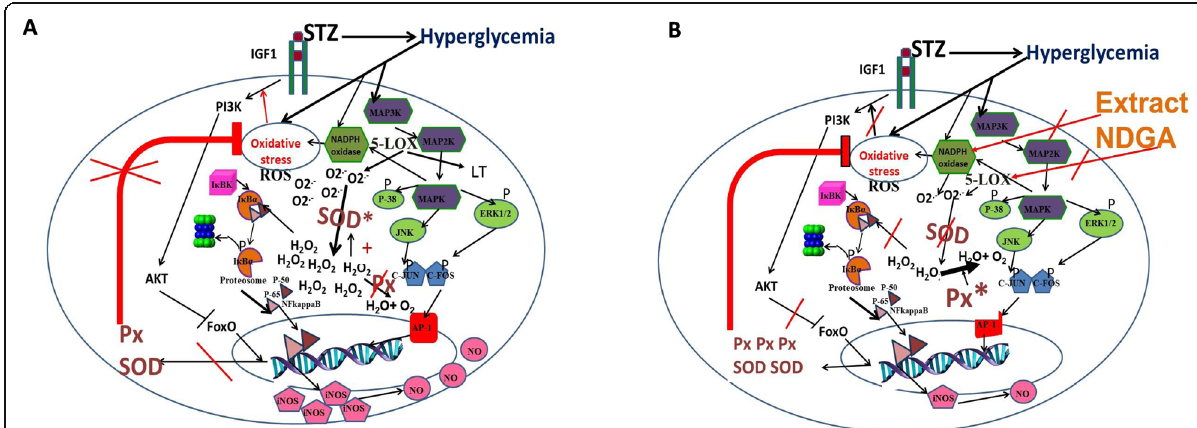
Fig. 7 Probable mechanism of the antioxidant action exerted by AE and NDGA on submandibular glands from diabetic rats. a - Hyperglycemia induces oxidative stress through MAPK, NADPH oxidase and 5-LOX activation. The ROS generated activate the IGF1R-PI3K-AKT pathway, which inhibites FoxO protein and decreases Px and SOD expression. Besides, Px activity is inhibited, leading to an increase in hydrogen peroxide levels. Hydrogen peroxide, in turn, activates SOD by oxidation and more hydrogen peroxide from superoxide anion is generated. Hydrogen peroxide activates the NFk-B pathway and the up-regulation of iNOS, leading to an increase of NO. b - The extract and NDGA inhibit NADPH oxidase and 5-LOX, thus decreasing superoxide anion levels and hydrogen peroxide formation. Low ROS levels activate FoxO protein, which induces the expression of Px and SOD. Moreover, Px is activated, so hydrogen peroxide is transformed into oxygen + water. Low levels of hydrogen peroxide do not activate SOD, therefore, less hydrogen peroxide is formed. NFk-B is not activated therefore, the iNOS expression decreases together with the production of NO.Inhibitory effects are marked in red, while stimulatory effects are marked in black.STZ: streptozotocin, ROS: reactive oxygen species, SOD: superoxide dismutase, Px: peroxidase, 5-LOX: 5 lipooxigenase, iNOS: inducible nitric oxide synthase, FoxO: Forkhead box O transcription factor; AKT: RAC-alpha serine/threonine-protein kinase; IGF1 R: insulin-like factor 1 receptor; PI3K: phosphoinositoside 3 kinase;